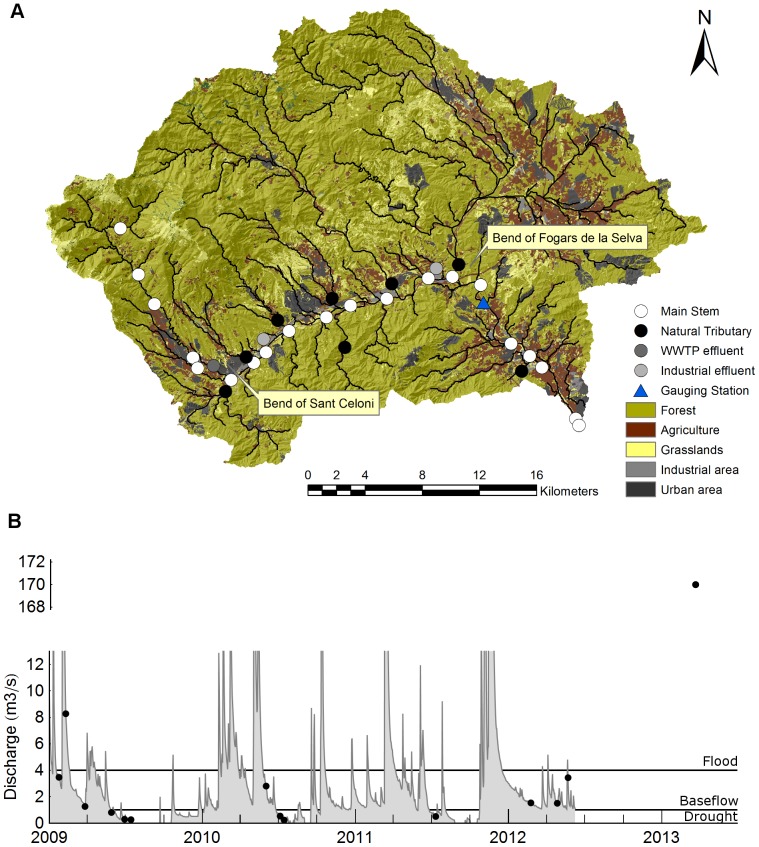
Experimental setting of the data set.A) Study site within the catchment from which the samples were collected. The river was operationally divided into three reaches: the “headwaters”, the “middle reaches” and the “lowland”. The divisions between segments correspond to the two big bends of Sant Celoni and Fogars de la Selva. B) Hydrogram contextualising the 15 sampling dates. Discharge data were recorded in the gauging station at Fogars de la Selva. Sampling dates were operationally divided into “flood” (Q>4 m3·s−1), “baseflow” (4>Q>1 m3·s−1) and “drought” (Q<1 m3·s−1) categories. As continuous monitoring was interrupted, the discharge on the last sampling date (2013/06/03) was measured individually on that date. All discharge data were provided by the Catalan Water Authority (Agència Catalana de l'Aigua, [24]).